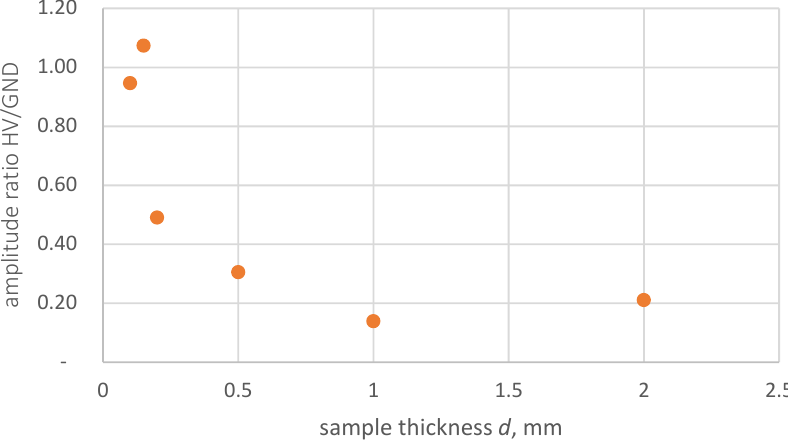
Figure 13. Impact of sample thickness d on the amplitude ratio HV/GND; pulser width t w = 5 ns, t r = 1 ns, PVDF sensor d s = 9 µ m, LDPE sample.